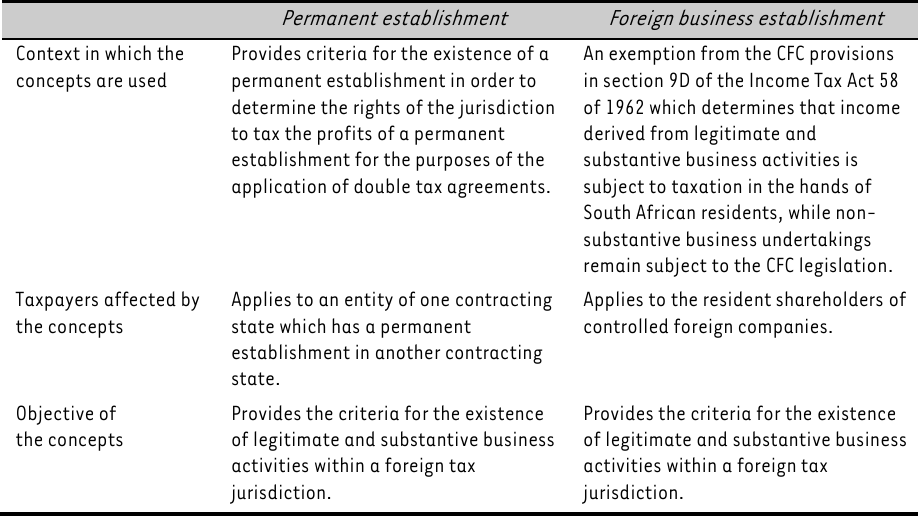
Comparison of the objectives of the concepts permanent establishment and